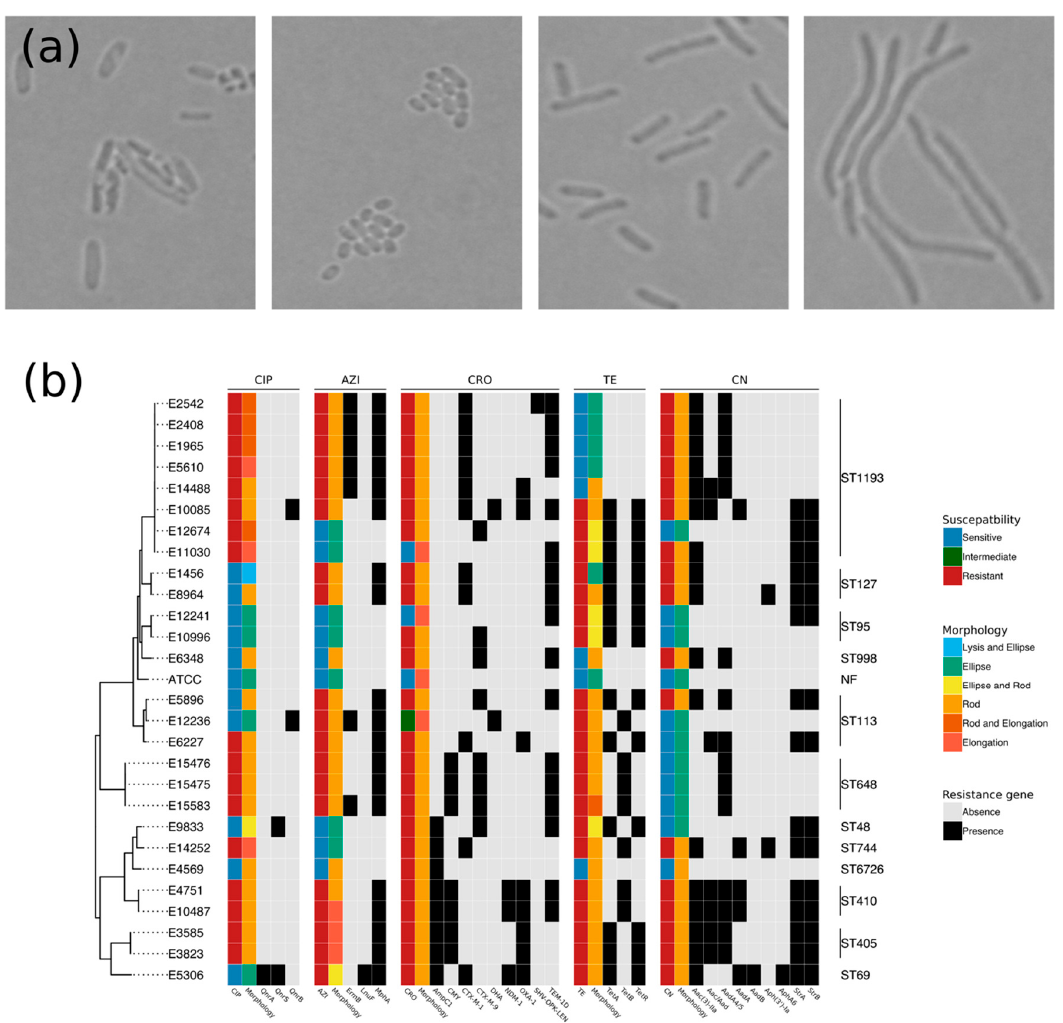
Figure 1. Bacterial morphology associated with antimicrobial resistance (AMR) and resistome. ( a ) The morphological features of E. coli after 3 h of being treated with ciprofloxacin. Brightfield images of E. coli in different morphologies, including, from left to right, cell lysis, ellipsoid, rod-like shape, and elongation, were acquired with a Nikon Ni-E upright microscope and a 100 × objective lens. Morphology of the reference strain is in rod-like shape in drug-free condition. ( b ) The phylogenetic structure of E. coli with corresponding susceptibility, AMR genes, and morphology. (Left) The unrooted phylogenetic tree constructed from core genomes of the 28 E. coli isolates. (Right) Sequence type (ST) of those isolates obtained by mapping the whole-genome reads to a database of seven housekeeping genes. (Middle) Five heatmap blocks, each of which demonstrates (first column) antimicrobial susceptibility, (second column) morphology under exposure to antimicrobials, and (remaining columns) the presence (black) and absence (gray) of resistance genes against quinolone (CIP: ciprofloxacin), macrolide (AZI: azithromycin), 𝛽 -lactam (CRO: ceftriaxone), tetracycline (TE), and aminoglycoside (CN: gentamicin). NF: non-identified ST .